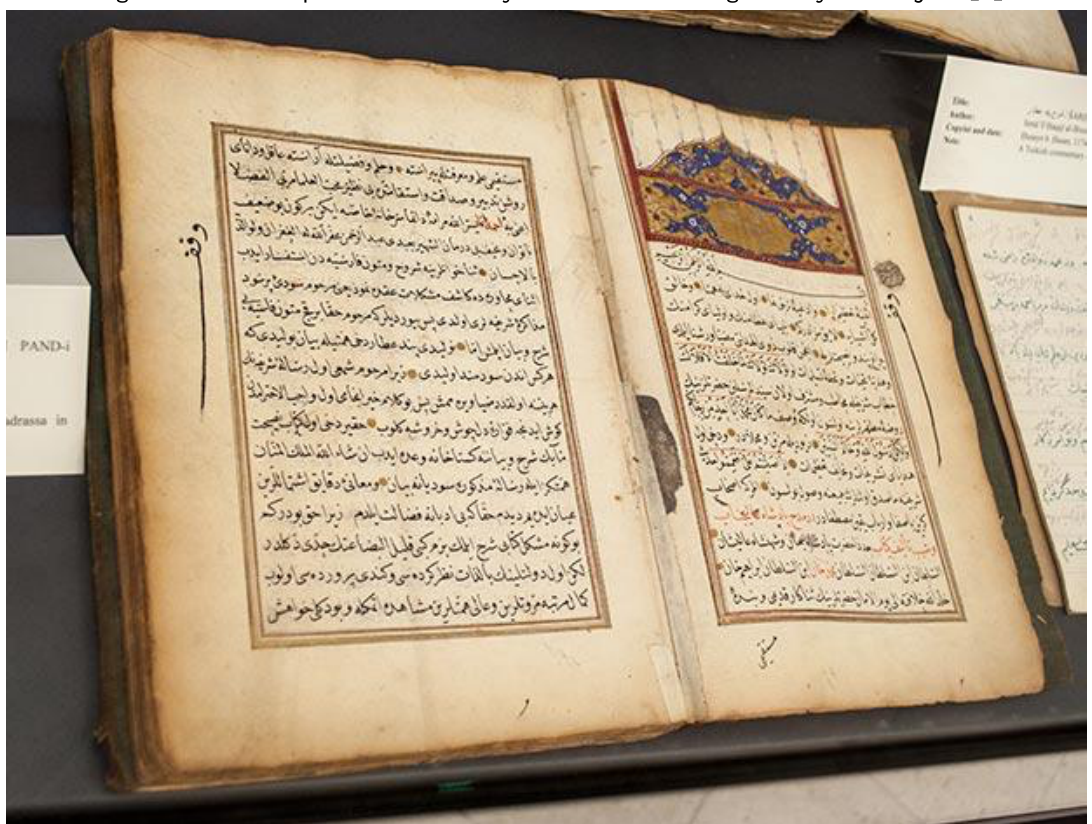
Figure 1. Manuscripts from the library of Gazi Husrev - beg Library in Sarajevo [2]